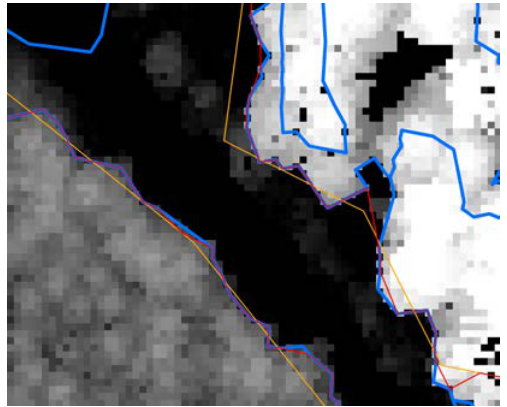
Figure 2. Refinement of segmentation outlines: orange = coarse segmentation, blue = fine segmentation, red = combined result.